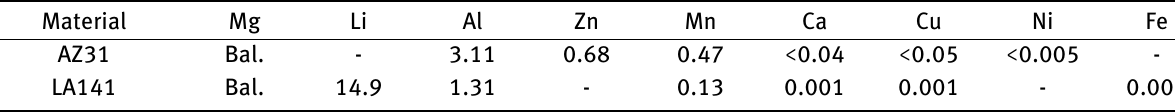
Table 1: Chemical compositions of LA141 Mg-Li alloy and AZ31 Mg alloy (mass, %).